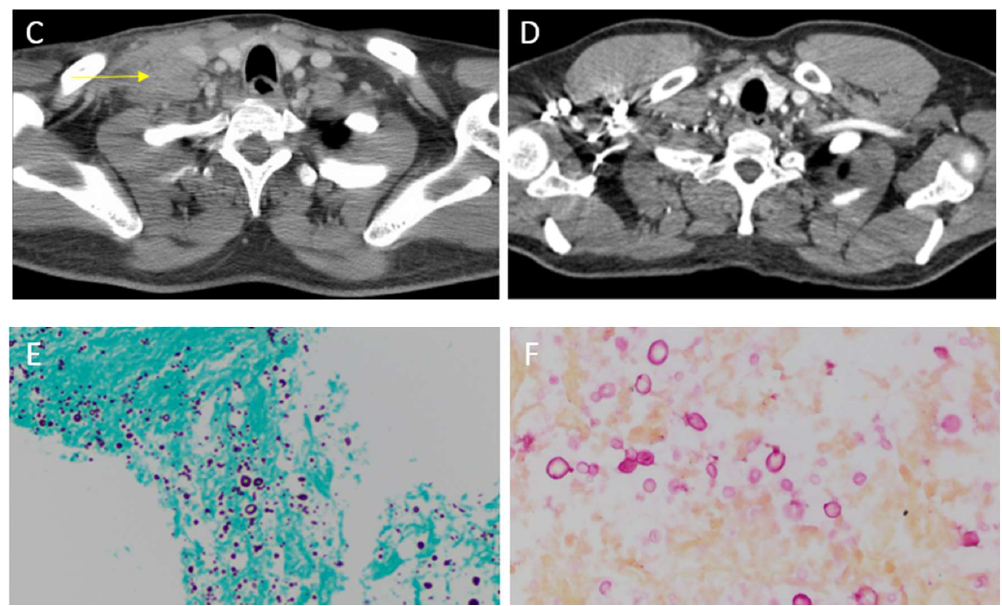
Figure 1. A 40-year-old Hispanic man presented to the hospital with headaches, dizziness, and progressive altered mental status for 1 week. His neurologic exam was significant for lethargy and neck stiffness. No focal deficits were noted. He was found to be infected with HIV. His CD4 count was 40 cells/μL, and his HIV viral load was 400,000 copies/mL. A lumbar puncture was performed and cerebrospinal fluid (CSF) analysis showed 15 white blood cells/mm 3 , a protein content of 60 mg/dL, and a glucose level of 20 mg/dL. The cryptococcal antigen from CSF was 1:512. A fungal culture from CSF isolated Cryptococcus neoformans. The patient was treated with 4 mg/kg/day of liposomal amphotericin and 100 mg/kg/day of flucytosine for 2 weeks (induction therapy). He developed marked improvement of his neurologic symptoms. Treatment was followed by consolidation therapy with 400 mg of fluconazole daily for 8 weeks. After 2 weeks of consolidation therapy, the patient started antiretroviral therapy, consisting of tenofovir alafenamide/emtricitabine, dolutegravir, and boosted darunavir (given the presence of the M184V mutation on the HIV genotype). After completing consolidation treatment, the patient was maintained on 200 mg fluconazole daily. He presented 15 months later with a painful neck swelling, fever, and chills. He stated that he had been compliant with HIV therapy and fluconazole. A physical exam revealed an enlarged and tender lymph node with purulent drainage in the supraclavicular region ( A ). To better characterize these findings and to evaluate extension into adjacent lymph nodes, we ordered a cervical computed tomography (CT) scan with contrast. This image showed a 6.2 × 4.3 cm heterogeneous mass (yellow arrow) anterolateral to the right scalene muscles, likely representing a conglomerate of necrotic lymph nodes ( C ). Laboratory studies showed a CD4 count of 227 cells/μL and an undetectable HIV viral load. He tested positive for serum cryptococcal antigen with a titer of 1:20. The patient was started on 15 mg/kg of vancomycin every 12 h and 1 g of ceftriaxone daily for a presumptive bacterial infection, and he continued with 200 mg of fluconazole daily. He underwent an ultrasound (US)-guided core biopsy of the lymph node. Histopathology showed granulomatous inflammation and necrosis with encapsulated pleomorphic round yeast with features suggesting Cryptococcus . Grocott’s Methenamine Silver stain highlighted the fungal elements ( E ). Their thick mucinous capsule stained bright red with mucicarmine special stain ( F ). Antibiotics were discontinued and the patient re-started induction therapy with liposomal amphotericin and flucytosine for possible cryptococcal relapse. He completed 2 weeks of induction therapy. After achieving significant clinical improvement, the patient was discharged with 400 mg of fluconazole daily. The final fungal cultures remained negative. At the 3-month follow-up, a physical exam showed near resolution of lymphadenitis ( B ). In addition, a CT scan showed a marked reduction in the necrotic mass ( D ). Cryptococcosis is a fungal infection typically associated with T-cell deficiencies, particularly acquired through immunodeficiency syndrome (AIDS), and it usually manifests as